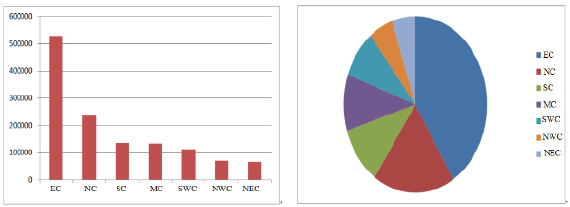
Figure 2. Zoning distribution of user access volume